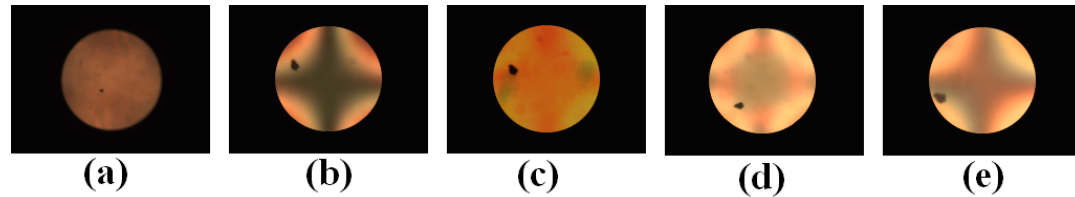
Figure 8. Conoscopic POM images of the LC cells made from PBHB# films on polyethylene terephthalate substrates according to the molar content of alkyl benzoate moiety (( a ) PBHB20, ( b ) PBHB40, ( c ) PBHB60, ( d ) PBHB80, and ( e ) PBHB100).